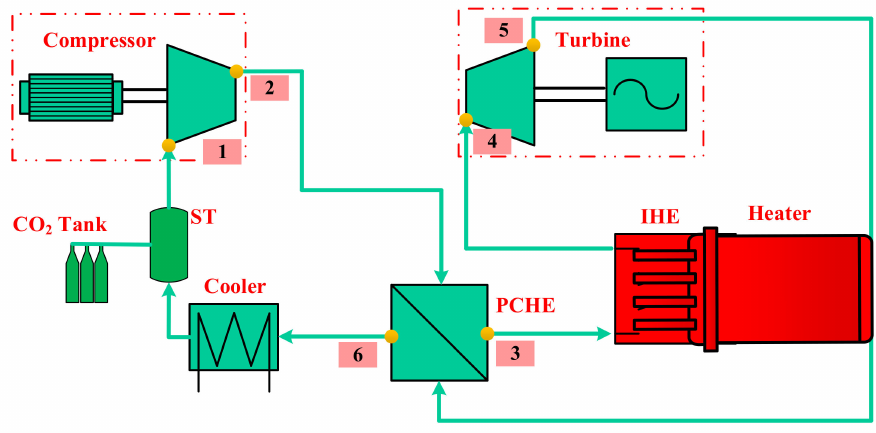
Figure 8. Simple regenerative cycle experiment system schematic diagram.